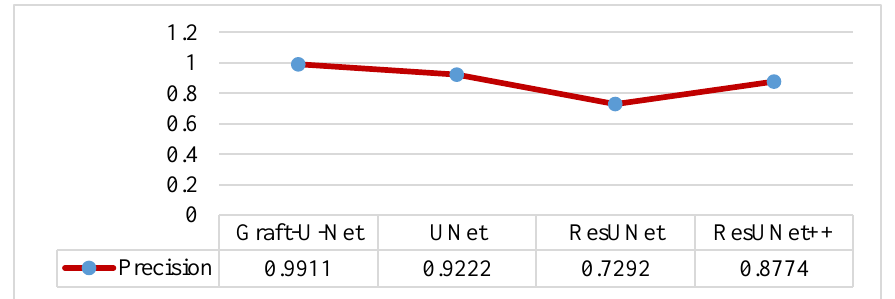
Figure 10. Comparison of Graft-U-Net on Kvasir-SEG dataset in terms of precision.